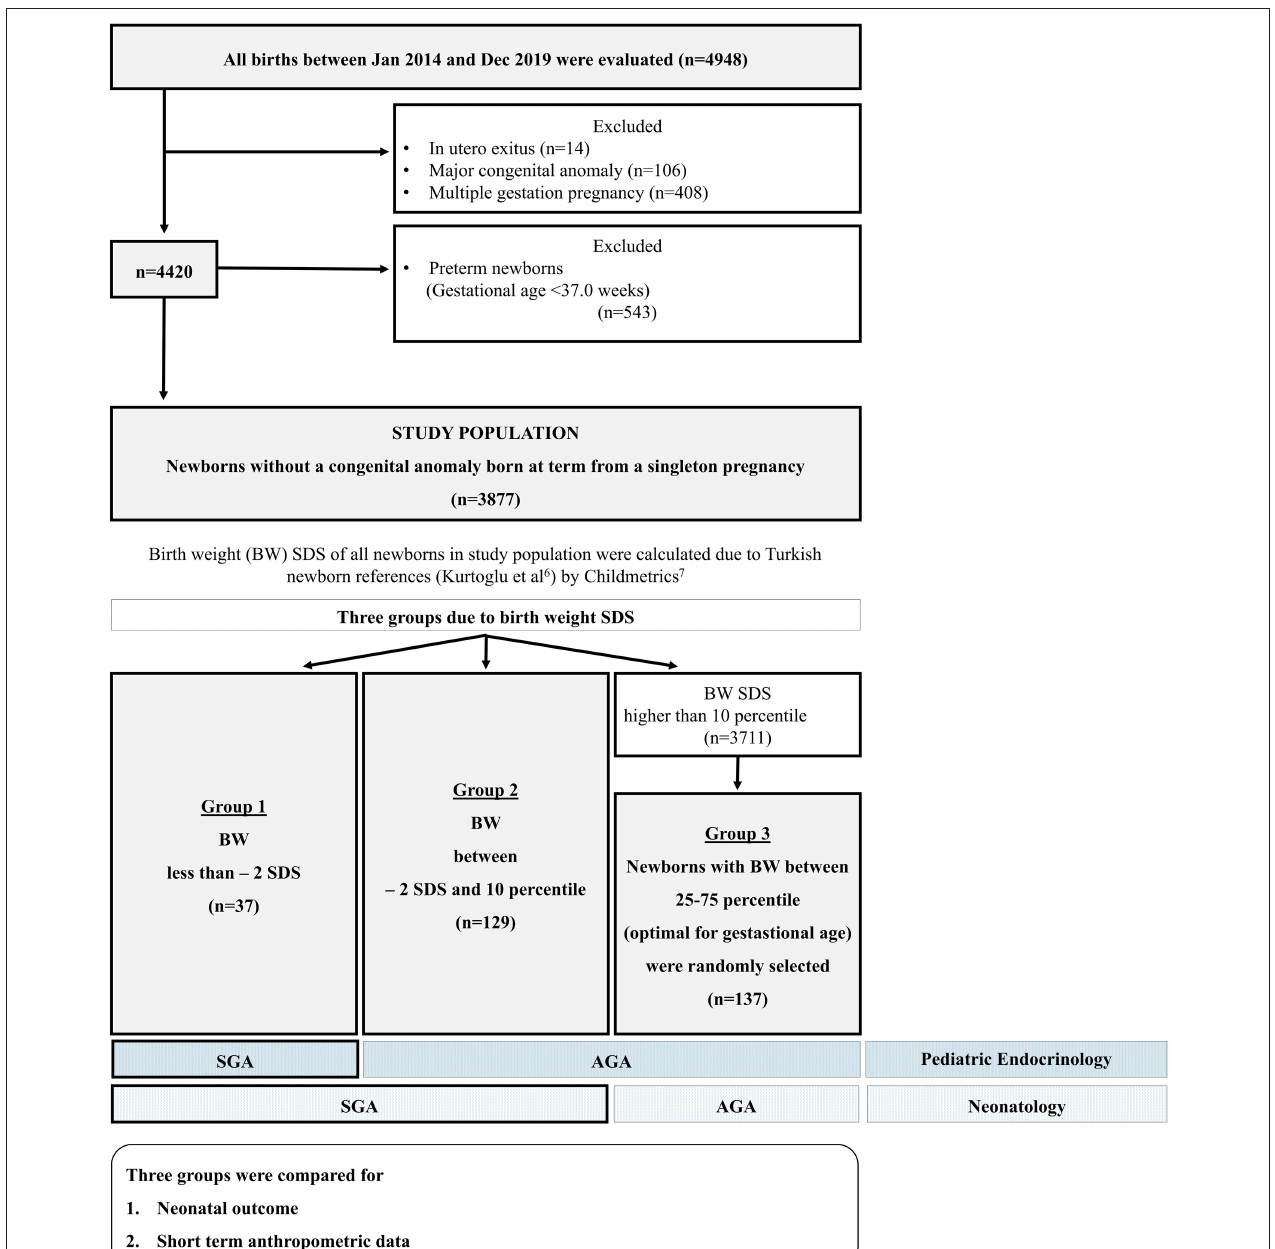
FIGURE 1 | Sample selection and study